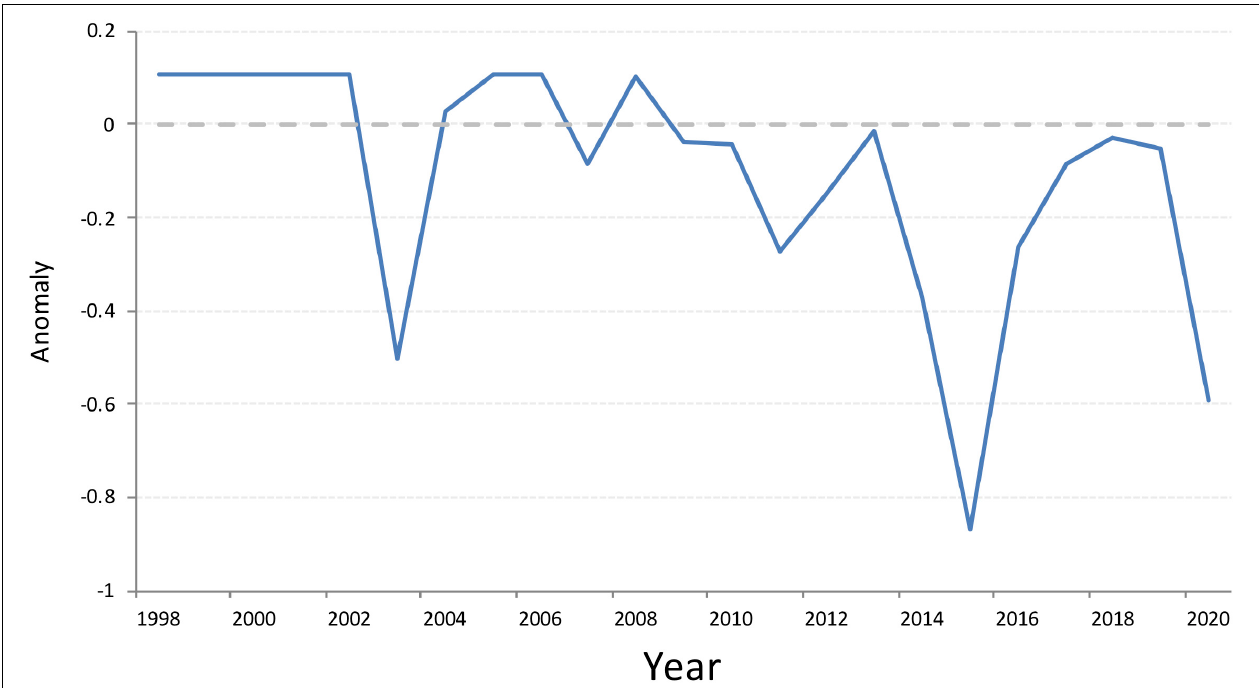
FIGURE 5 | Extent of drift ice, 4/10 and greater, coverage in the White Sea 1998-2020, expressed as anomalies from the average ice coverage 2000-2010. Data obtained from the Norwegian Ice Service (https://cryo.met.no/archive/ice-service/icecharts/quicklooks/).